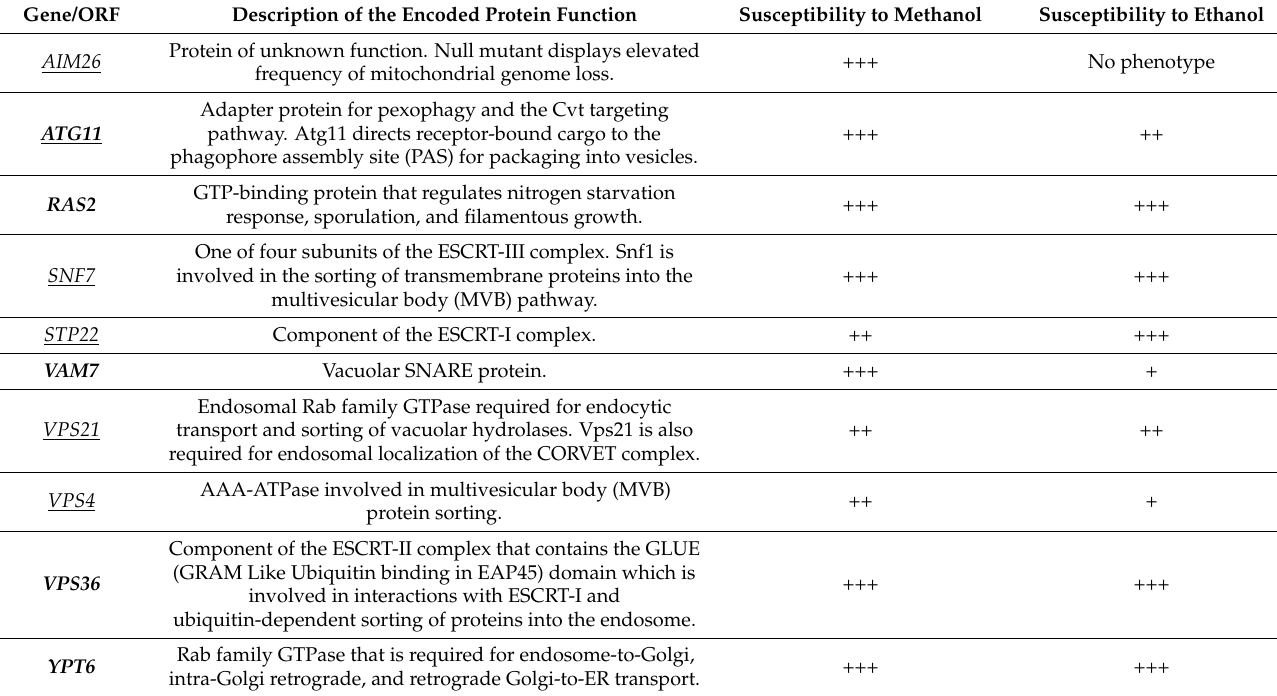
Table 2. Genes involved in autophagy identified in this study as determinants of yeast tolerance to methanol, compared with ethanol. Genes in bold are specific to macroautophagy and the corresponding mutants exhibited a strong susceptibility phenotype, and the underlined genes are specific to reticulophagy. Atg11 is common to both types of autophagy. Symbols are as in Table 1. Gene/ORF Description of the Encoded Protein Function Susceptibility to Methanol Susceptibility to Ethanol